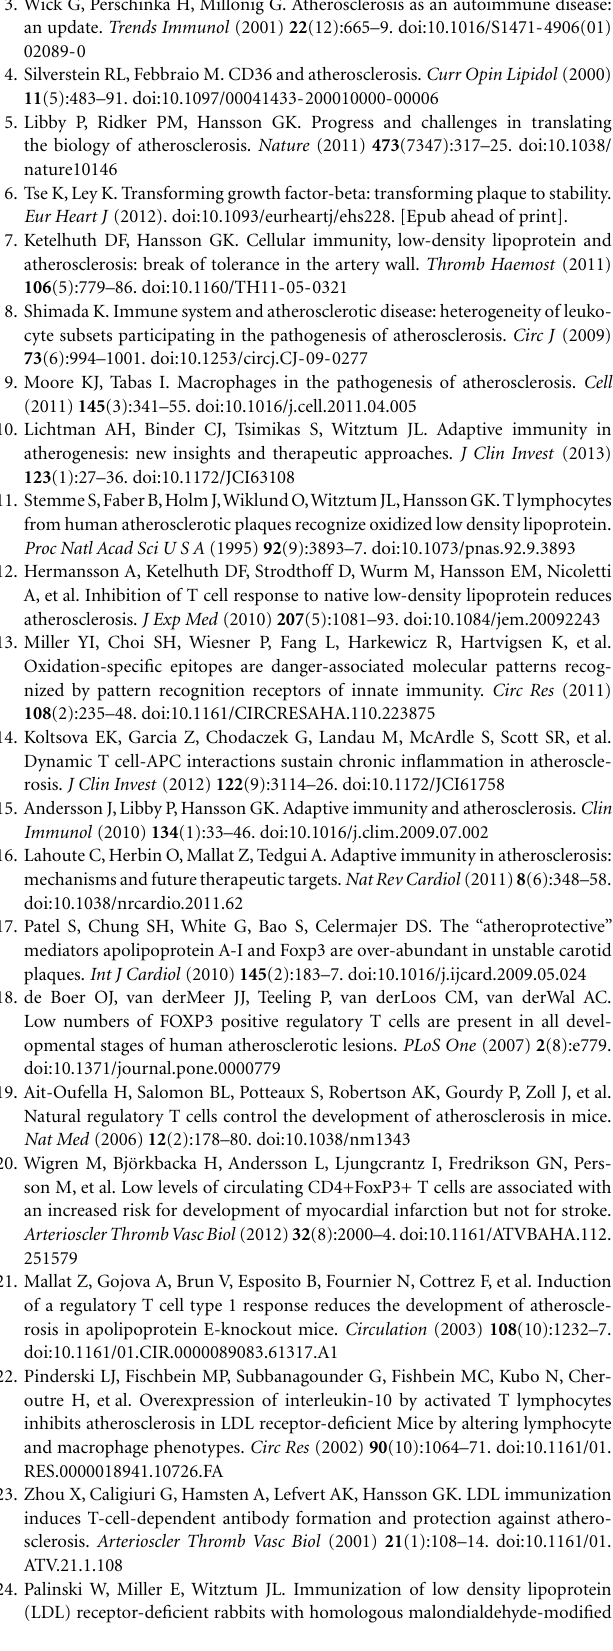
Table S1 |Antigen-specificT-cell proliferation . Mice were immunized with either ApoB 3501–3516 , ApoB 978–993 , PPD (positive control), or MOG 35–55 (negative control). Draining lymph node cells were harvested 10days later and incubated with the relevant peptide, PPD or MOG 35–55 . Proliferative responses were measured by 3 H incorporation and expressed as SI.We show here that there are antigen-specificT-cell responses to both ApoB 3501–3516 and ApoB 978–993